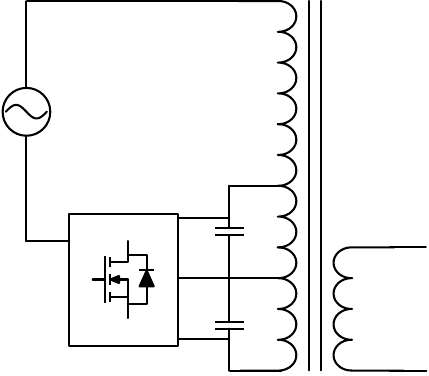
Figure 2. Active hybrid solid state transformer.